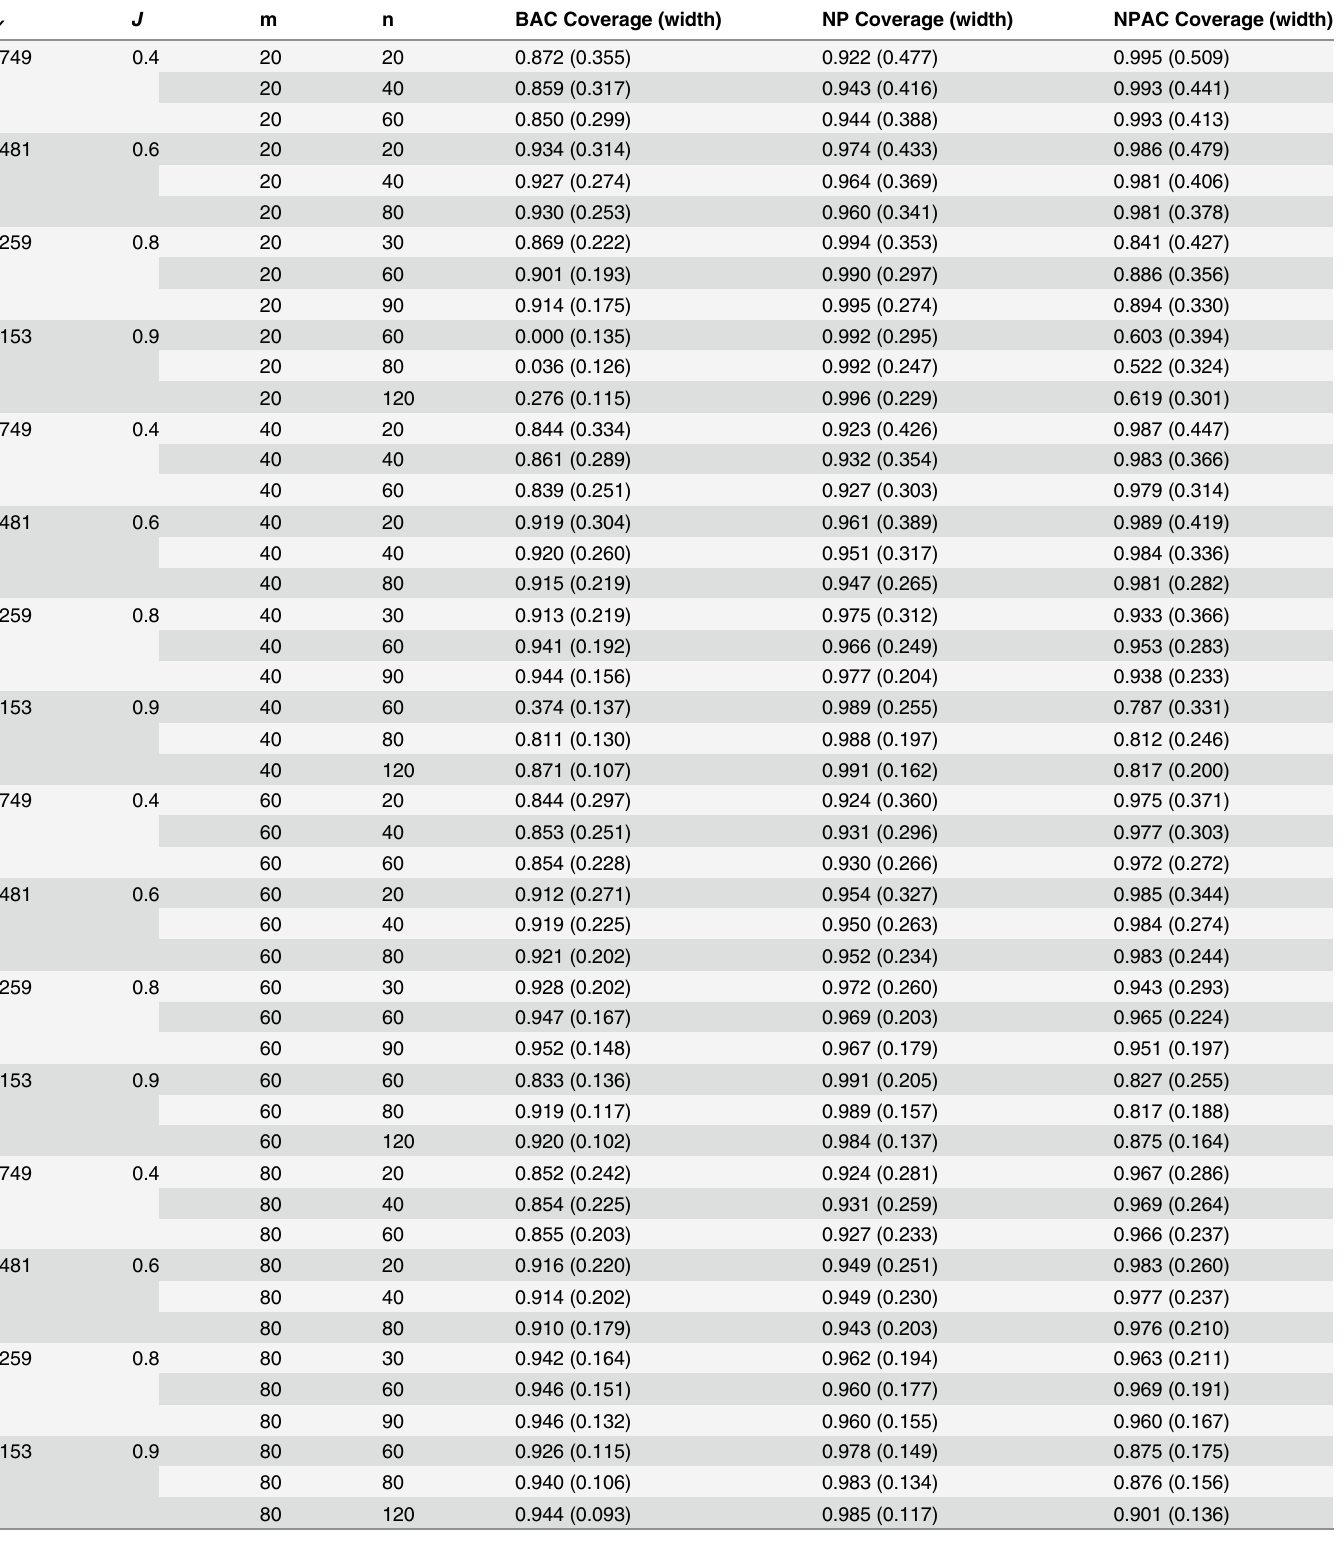
Table 10. Mixed distribution (normal distribution and gamma distribution): coverage probabilities and average widths at the 95% nominal